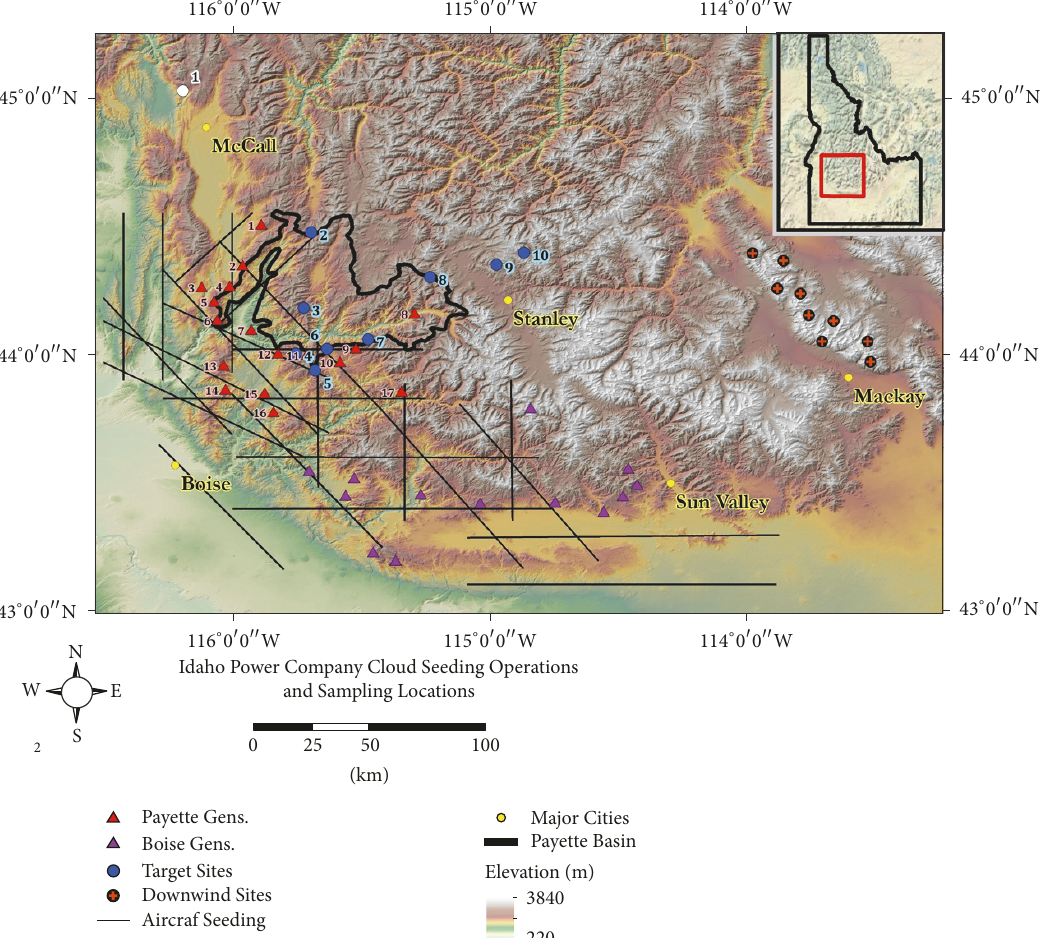
Figure 1: IPC uses ground generators (red triangles) and aircraft (lines) to deliver AgI. Sampling sites in and around the Payette River Basin were targeted for precipitation enhancement (blue dots). Sites downwind of operations were sampled as well (orange crosses). Site 1 (white dot) was the sole control site for this